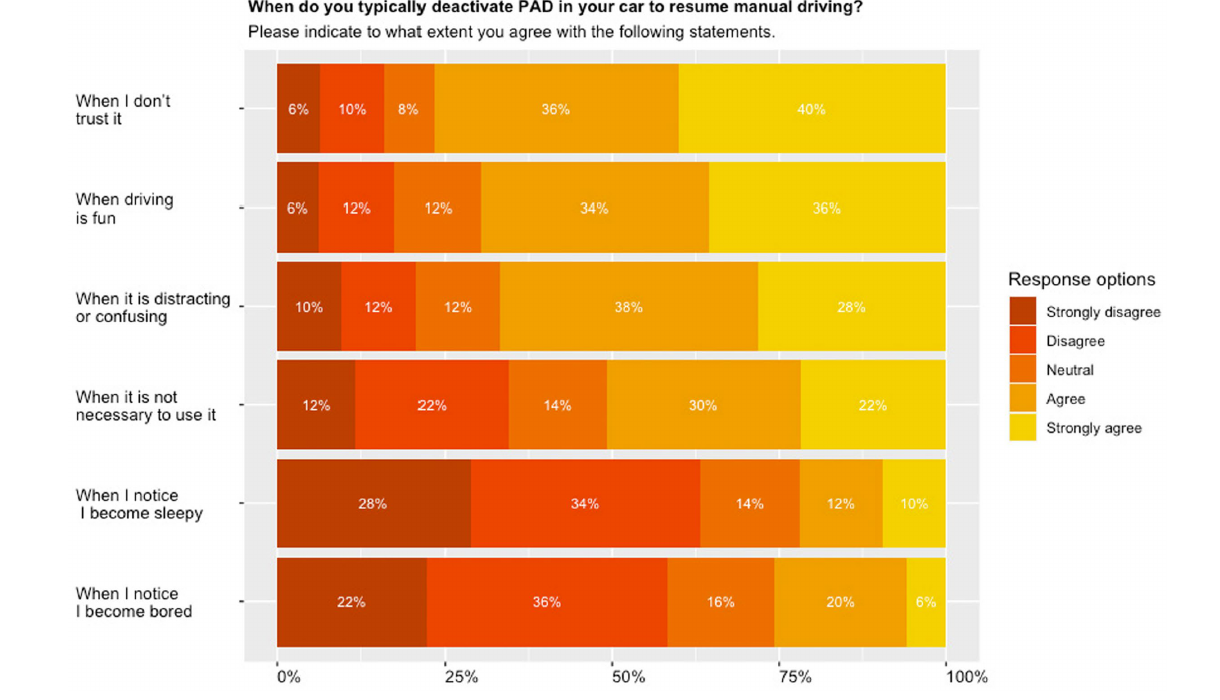
FIGURE 2 Driver-initiated disengagement of partial automation; stacked bar plots presenting relative proportions of questions pertaining to disengaging partial automation sorted from highest (top) to lowest (bottom). PAD = partially automated